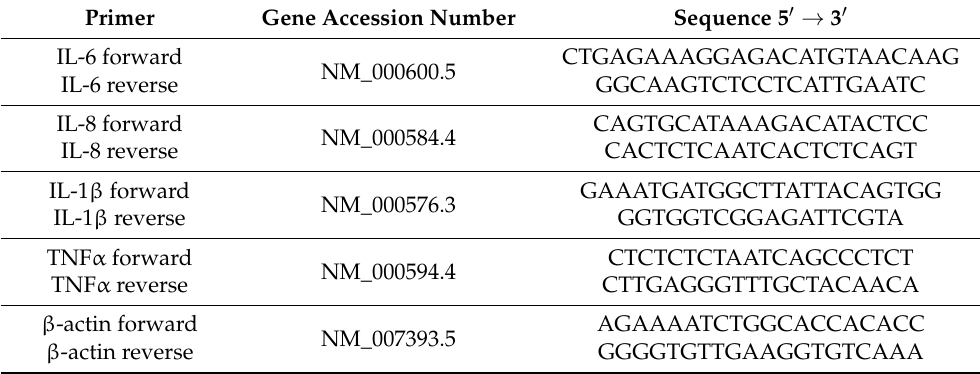
Table 1. Real-time PCR gene